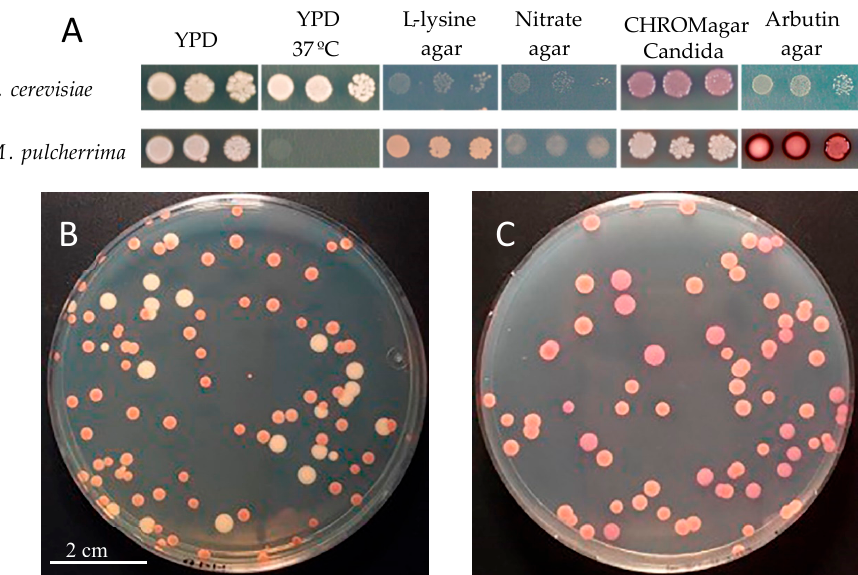
Figure 2. ( A ) Development and colony appearance in several growth media and di ff erent culture conditions (temperature). ( B ) Metschnikowia pulcherrima ( Mp ) orange colonies, some of them surrounded with white halos and Saccharomyces cerevisiae ( Sc ) white / creamy colonies in YPD media. ( C ) Mp and Sc in CHROMagar ® media. Sc: bigger colonies with light pink color, Mp : smaller orange colonies, some of them with white